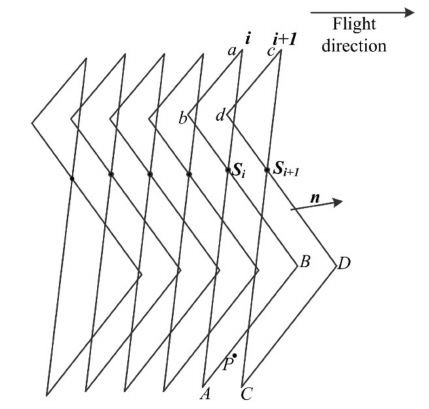
Figure 4. The illustration of exact scan line determination using the geometric constraints in object